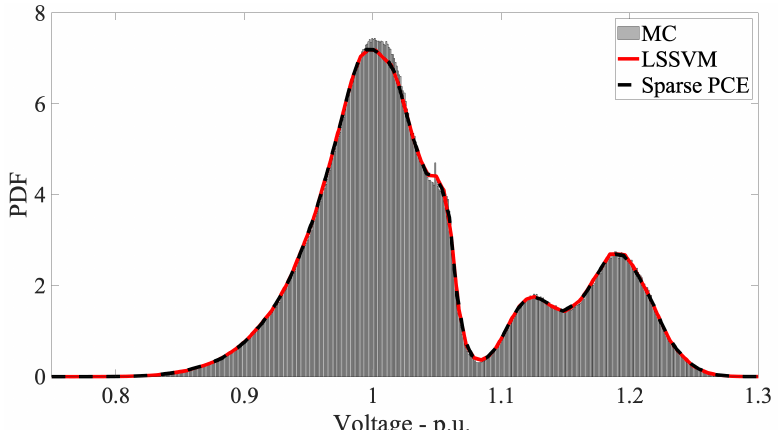
Figure 11. PDF of the per-unit (p.u.) magnitude of the nodal voltages calculated for Case 2 from the MC samples and with the compressed LS-SVM and sparse PCE surrogate